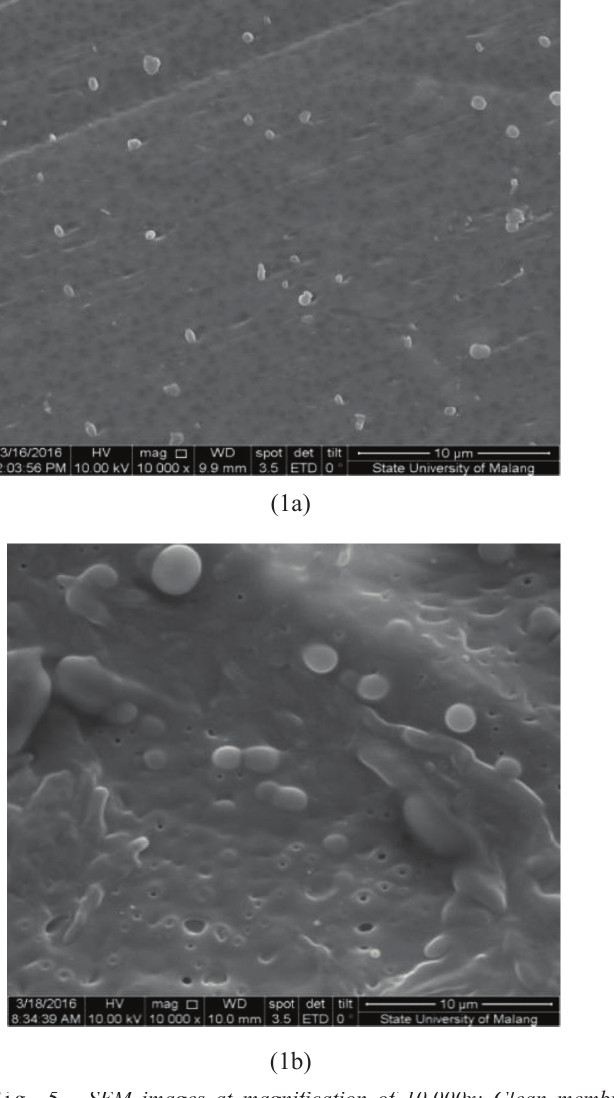
Fig. 5 – SEM images at magnification of 10,000x: Clean membranes (1a- Surface), (2a- Cross-sectional structure) and fouled membrane after ultrafiltration of 30 % CPO-solvent mixture (1b-Surface), (2b-Cross-sectional